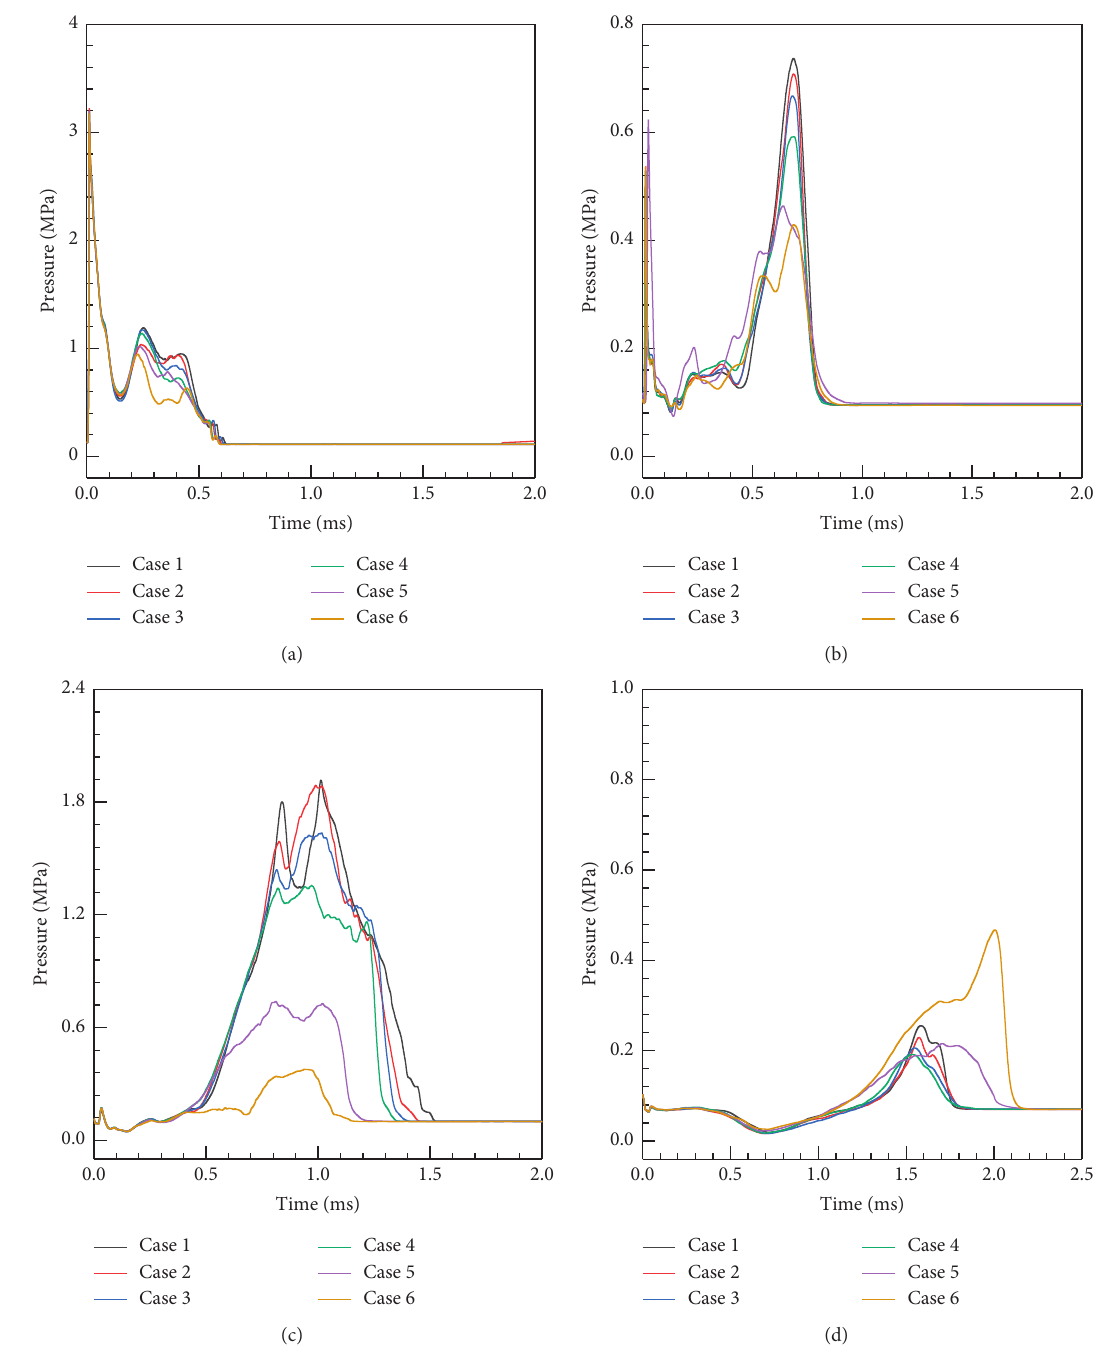
Figure 13: Pressure under different cases: (a) A 6, (b) B 6, (c) C 3, and (d) D